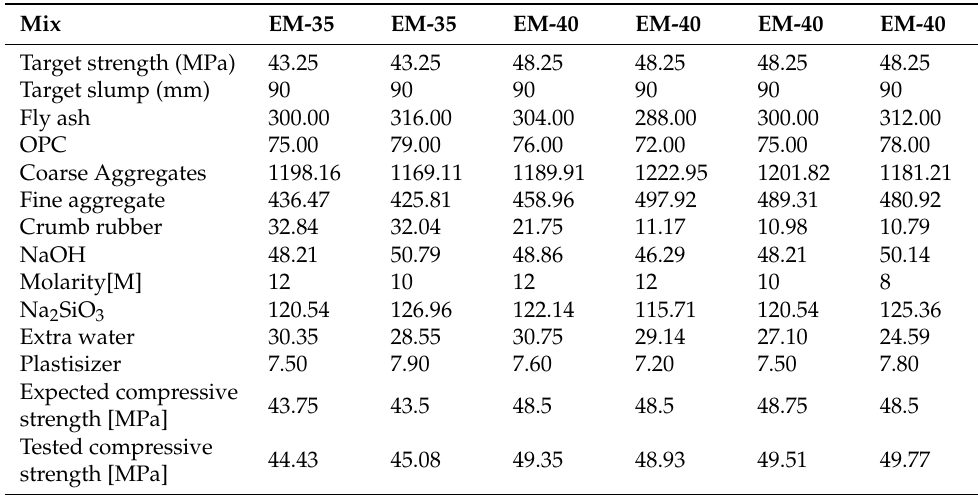
Table 6. Mix design quantities (kg) carried out using the above